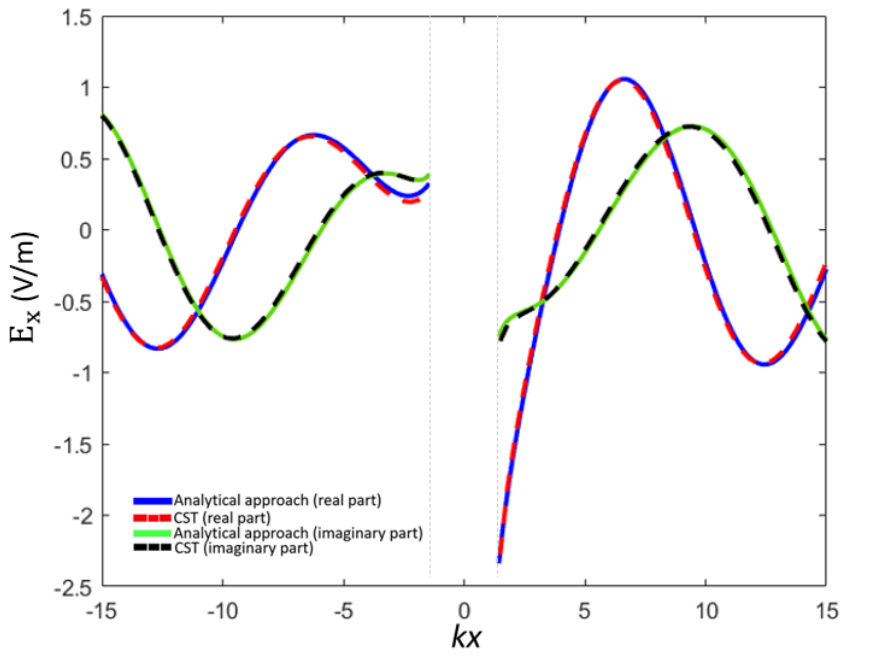
Figure 13. Real and imaginary parts of E x : comparison between the analytical approach implemented in Matlab and CST Microwave Studio, for the geometry of Figure 2. TM